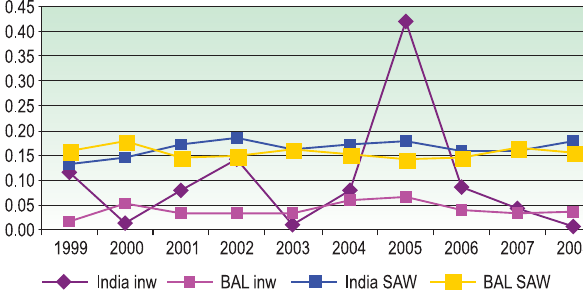
Fig. 8. FDI growth rates vs aggregated index SAW (the second situation)